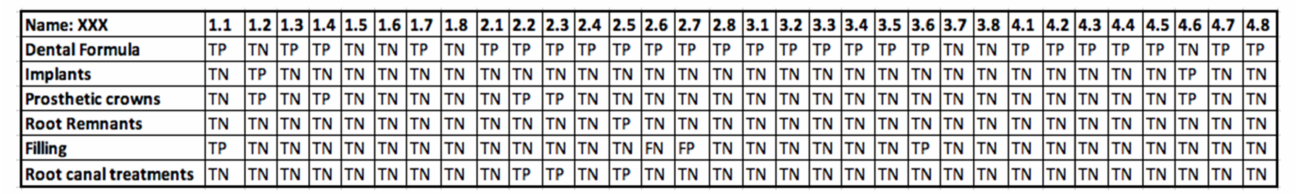
Figure 6. An example of data collected from an OPG using an Excel